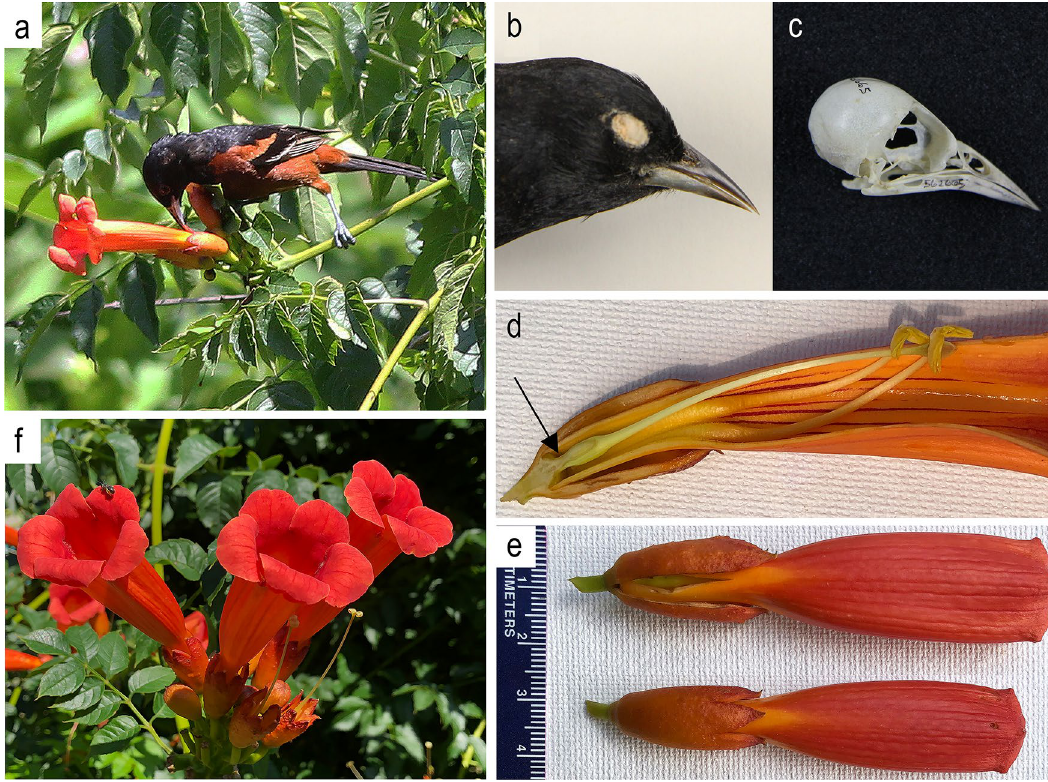
Figure 1. Orchard oriole ( Icterus spurius ) and trumpet creeper ( Campsis radicans ) flowers. Clockwise from upper left: ( a ) Male oriole (ASY) piercing corolla. ( b ) Museum specimen of male oriole. ( c ) Skull of male oriole showing the retroarticular processes, instrumental in bill-gaping, at the posterior ends of the mandibular rami. ( d ) Sagittal section of flower showing the location of the nectar receptacle (arrow) at the base of the corolla. ( e ) Dorsal view of unopened buds. The upper bud displays a typical oriole piercing that split the dorsal and lateral calyx lobes. The lower bud is unpierced. ( f ) Cyme with developing buds, open flowers, and empty